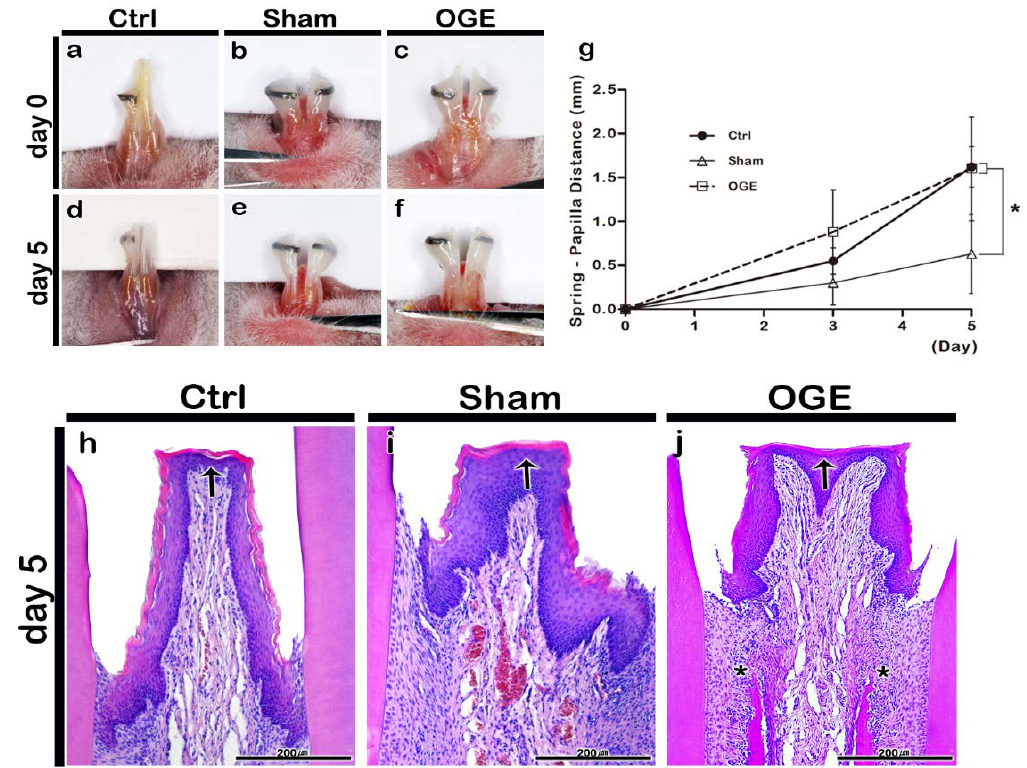
Figure 2. Morphological and histological changes of interdental papilla (IDP) after the wire attachment. Morphology of IDP in control ( a , d ), sham ( b , e ), and open gingival embrasure (OGE) ( c , f ) groups on days 0 ( a – c ) and 5 ( d – f ) post-wire attachment. Change in spring-papilla distance (SPD) value during the wire attachment period ( g ). The SPD values in OGE and control groups were significantly higher than those in sham group ( p < 0.0167). Histological analysis of IDP in the control ( h ), sham ( i ), and OGE ( j ) groups after wire attachment. Arrows and asterisks indicate the IDP and high cell density around the alveolar bone, respectively. * p -value was obtained from Kruskal–Wallis test, followed by Bonferroni’s post hoc test ( p < 0.0167). Scale bars = 200 μm ( h – j